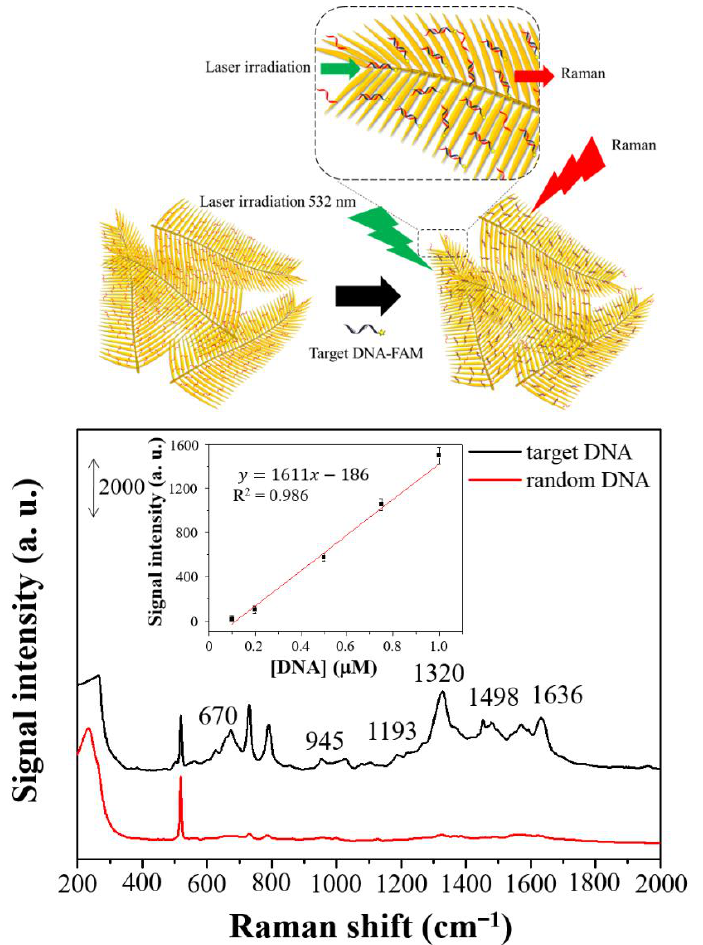
Figure 12. A cartoon representation of DNA sensing: Schematic of DNA sensing by the dendritic forest-like Ag nanostructures. SERS spectra of FAM obtained for a target single-stranded DNA (1.0 µM, black line) and random single-stranded DNA (1 µM, red line) attached to the dendritic forest-like Ag nanostructures. Linear responses (inset) of the Raman intensity plotted with respect to the concentration of target DNA. The error bars represent the standard deviations by using three batches of Ag substrates for which the average signal of 10 spots per sample are recorded.